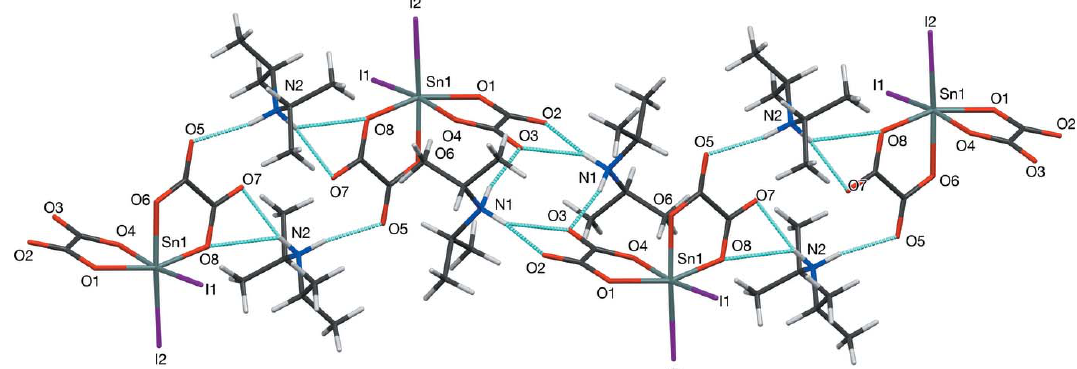
Figure 2 Perspective view of an infinite chain in (I), showing the two types of hydrogen bonds as light-blue dashed lines.